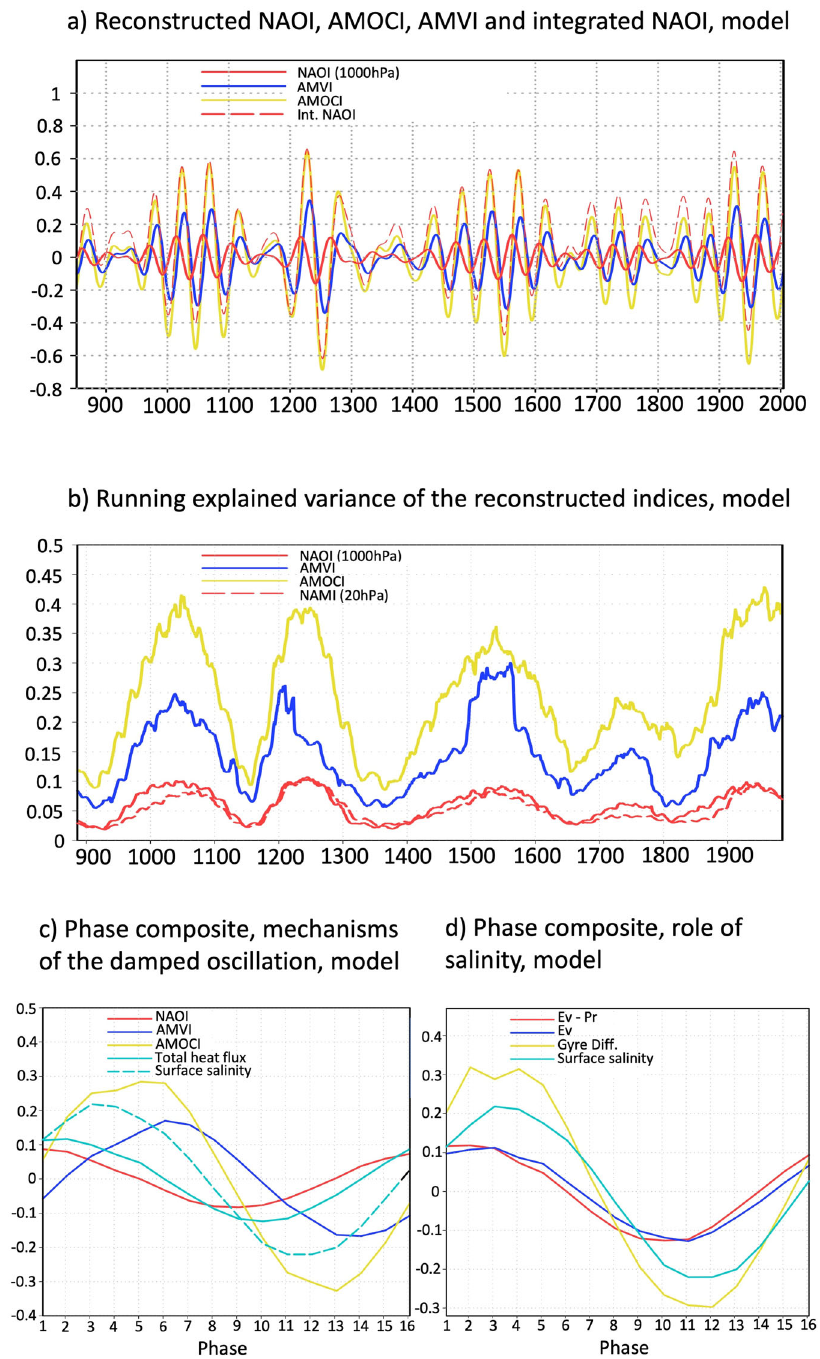
Fig. 3 Stratosphere/troposphere/ocean coupled damped multidecadal oscillation in model simulation. a The reconstructed NAOI (red), AMVI (blue), AMOCI (yellow) and scaled time-integrated NAOI (dashed red) from the coupled multidecadal stratosphere/troposphere/ocean variability using MSSA. b Running explained variance of the AMVI (blue), NAOI (red), NAMI at 20 hPa (dashed red) and AMOCI (de fi ned as Atlantic Ocean Meridional Overturning Mass Stream function averaged, around the climatological maximum, 0 – 2000 m and 30to40N, yellow). c The averaged periodic evolution over 16 phases of multidecadal changes (using phase-composite, Methods) of the reconstructed multidecadal NAOI (red), AMVI (bleu), AMOCI (yellow) surface salinity (dashed green), and the averaged upward turbulent oceanic heat- fl uxes (green) over Labrador Sea. d The same as c but for the reconstructed Gyre index (de fi ned as difference in the barotropic mass stream function between subtropical and subpolar gyre (Methods, yellow)) and the reconstructed average over Labrador Sea of the Evaporation (Ev, blue), surface salinity (green) and difference between evaporation and precipitation (Ev – Pr, red). All indices in a – d have been standardized by dividing the resulting deviations from the mean by the standard deviation, in such way that the values express the portion of the standard deviation explained by the multidecadal